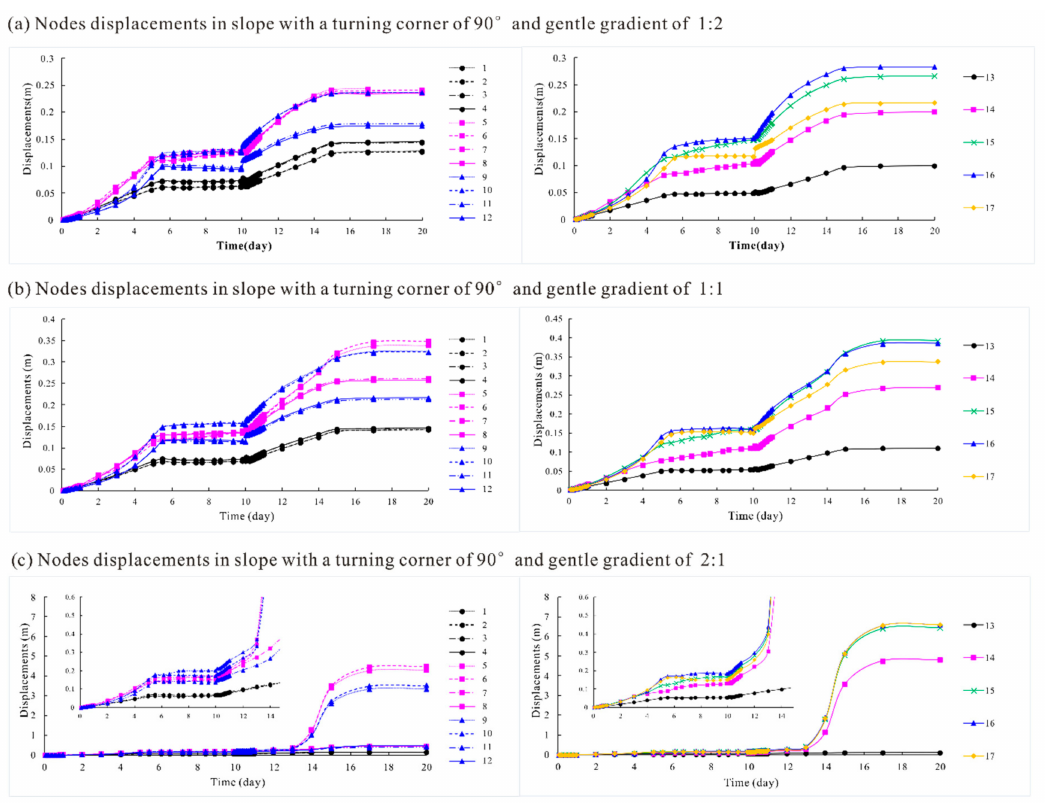
Figure 15. Deformations of monitoring nodes for di ff erent slope gradients with a small turning corner of 90 ◦ : ( a ) slope gradient = 1:2; ( b ) slope gradient = 1:1 and ( c ) slope gradient =